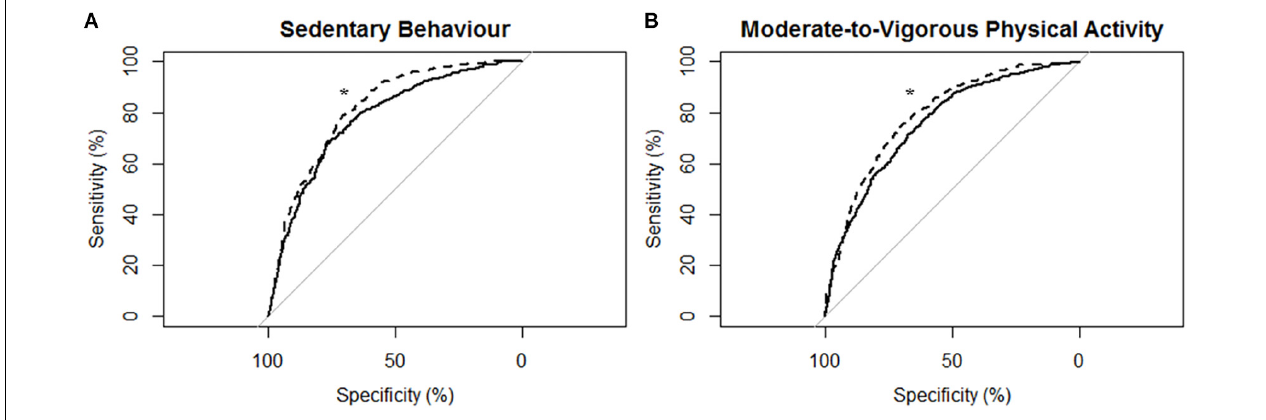
FIGURE 2 | Receiver operating characteristic (ROC) curves and corresponding area under the curves (with 95% confidence interval; AUC) for all participants ( N = 43) with the MotionWatch8 (MW8) placed on either the non-affected side or the stroke affected side. (A) ROC curve for sedentary behavior with MW8 placed on the non-affected side (–) vs. affected side (- - -). We found there was moderate diagnostic accuracy for the non-affected side (AUC = 0.777; 95% CI: [0.754–0.801]), and moderate diagnostic accuracy for the affected side (AUC = 0.814; 95% CI: [0.794–0.834]). (B) ROC curve for moderate-to-vigorous physical activity with MW8 placed on the non-affected side (–) vs. affected side (- - -). We found there was moderate diagnostic accuracy for the non-affected side (AUC = 0.758; 95% CI: [0.738 – 0.779]), and moderate diagnostic accuracy for the affected side (AUC = 0.792; 95% CI: [0.773–0.810]). ∗ Significant difference in diagnostic accuracy between ROC curves (DeLong et al.,